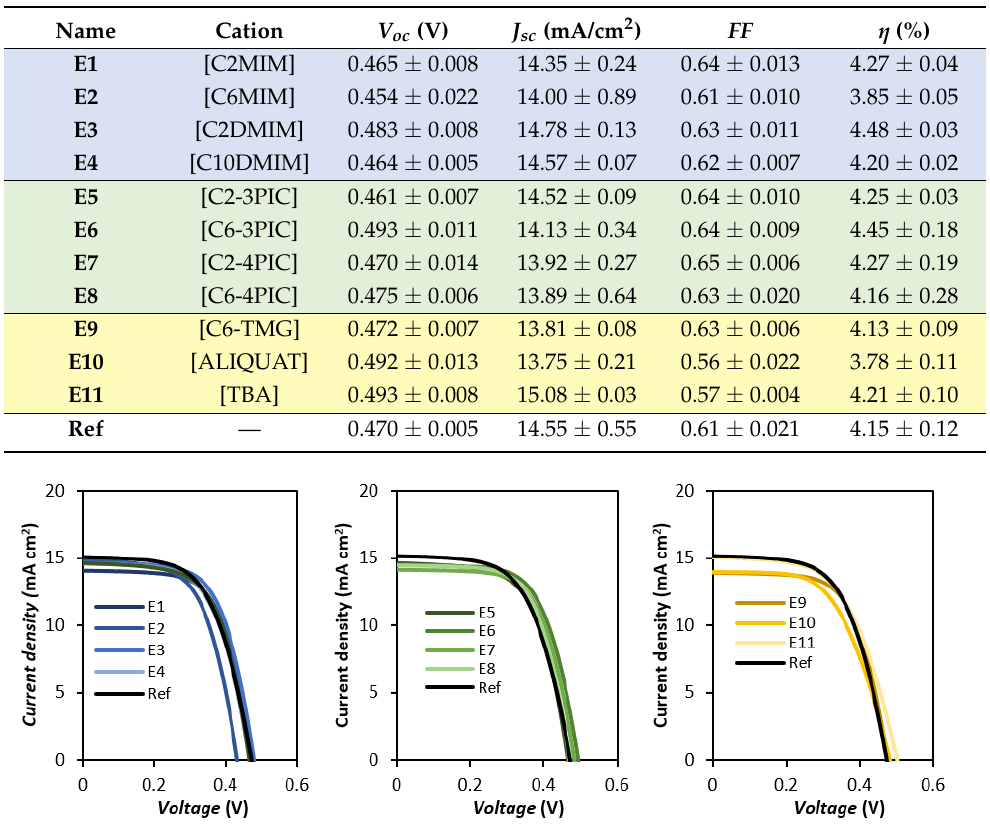
Figure 3. J - V curves of the test cells employing the various the iodide-based organic salts as additives under 100 mW cm − 2 simulated AM 1.5G illumination. The above results correspond to the best performing cell.